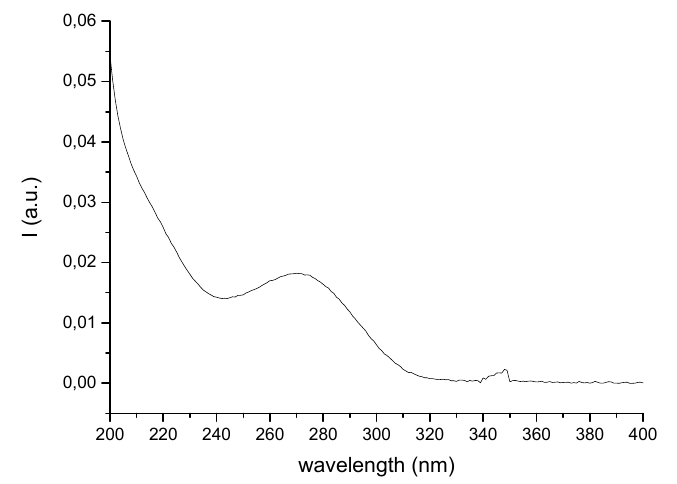
Figure A2. UV absorption spectra of 250 μ L PLA NPs water solution in 3 mL of acetonitrile.